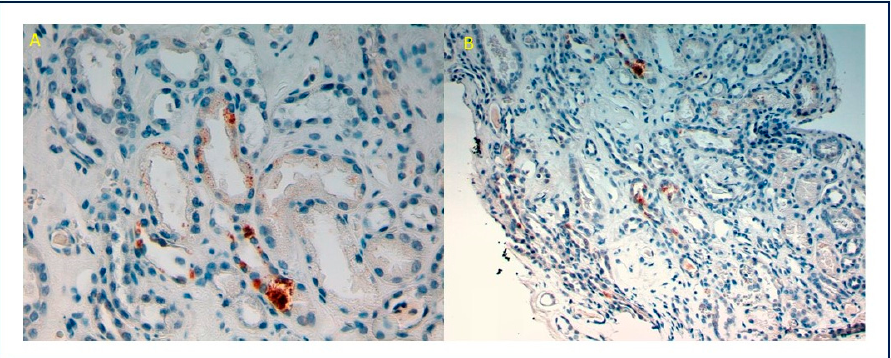
Figure 4. ( A ) (10×), ( B ) (20×): Positive immunostain for SARS-CoV-2 with a granular cytoplasmic pattern in tubular epithelial cells.